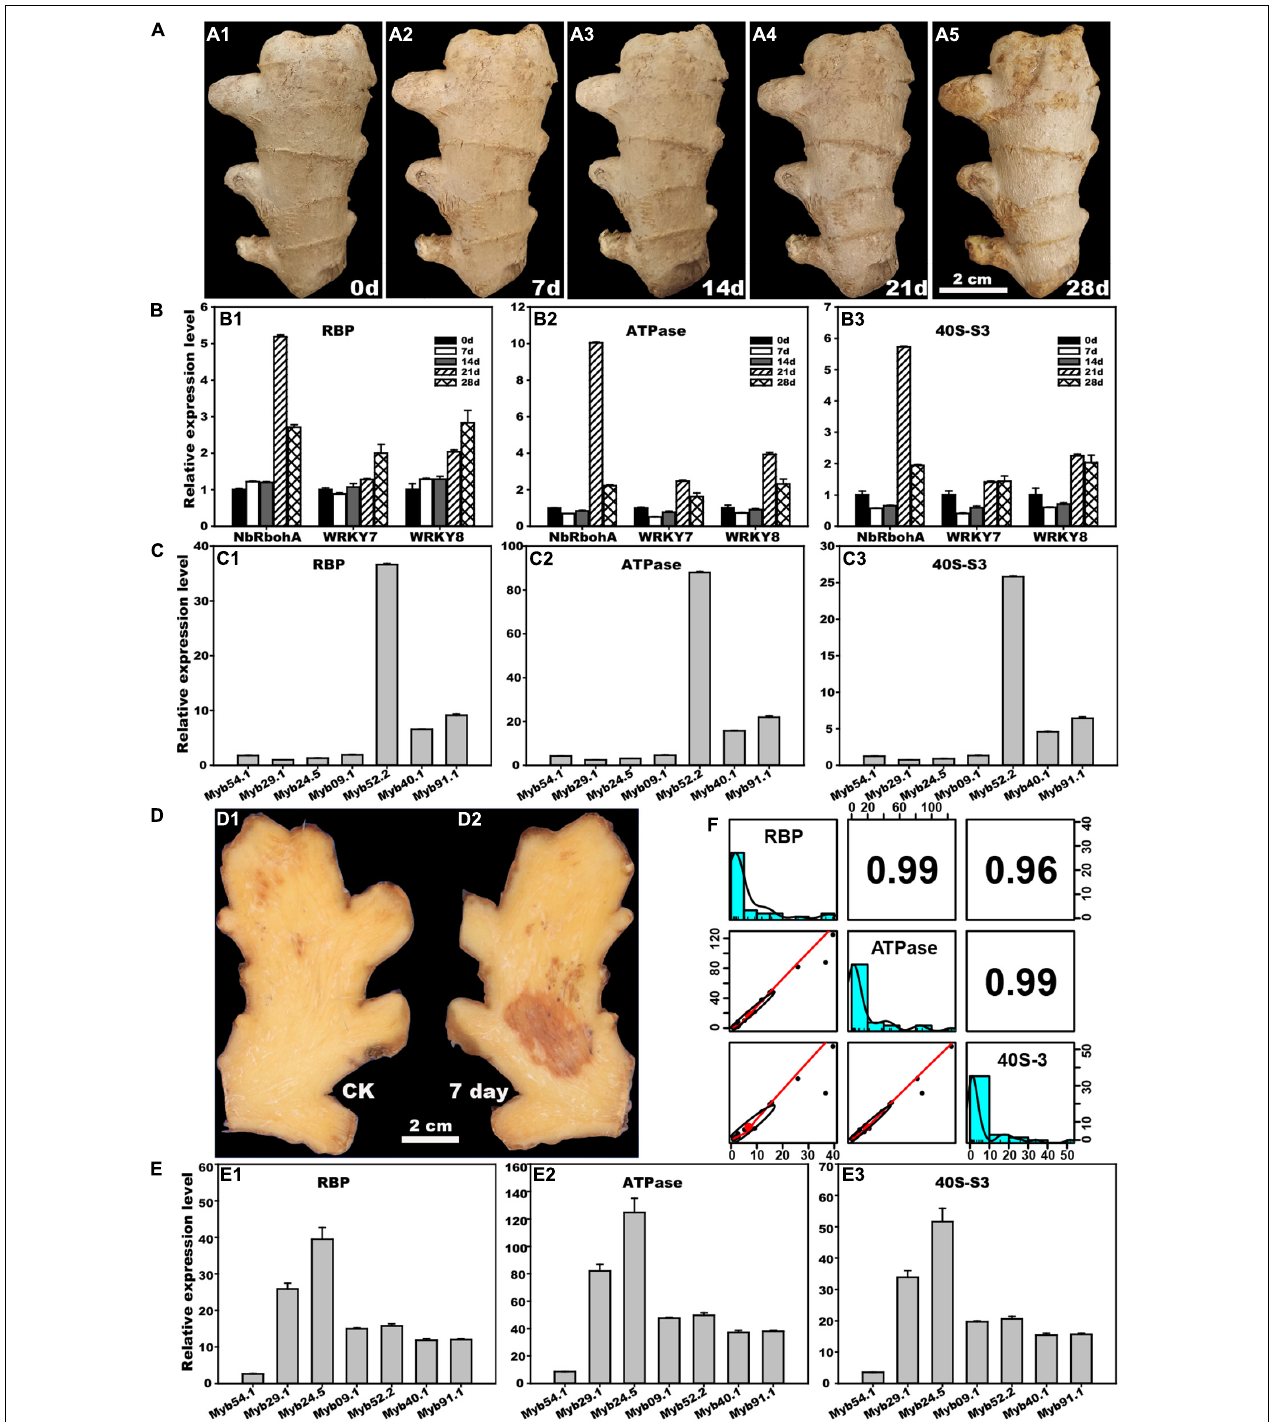
FIGURE 3 | Application of stability reference genes RBP , ATPase , and 40S-S3 to postharvest ginger. (A) Natural deterioration of ginger rhizome during 0 to 28 days postharvest storage. (B) Changes in relative expression levels of three pathogenesis - related genes during rhizome postharvest storage determined by RBP , ATPase , and 40S-S3 . (C) Changes in the relative expression level of seven flavonoid-related MYB genes during rhizome 7 days natural postharvest storage determined by RBP , ATPase , and 40S-S3 . (D) Disease lesion of the rhizome after inoculation by Fusarium solani for 7 days. (E) Changes in the relative expression level of seven flavonoid-related MYB genes after rhizome inoculation by F . solani for 7 days determined by RBP , ATPase , and 40S-S3 . (F) Validation stability by correlation analysis of the relative expression levels of three pathogenesis - related and seven flavonoid-related genes determined by RBP , ATPase , and 40S-S3 above.